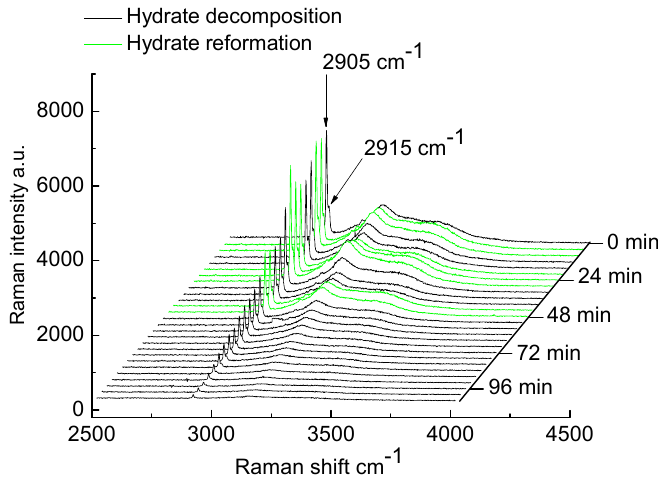
Figure 5. Methane hydrate decomposition at 245 K and atmospheric pressure.